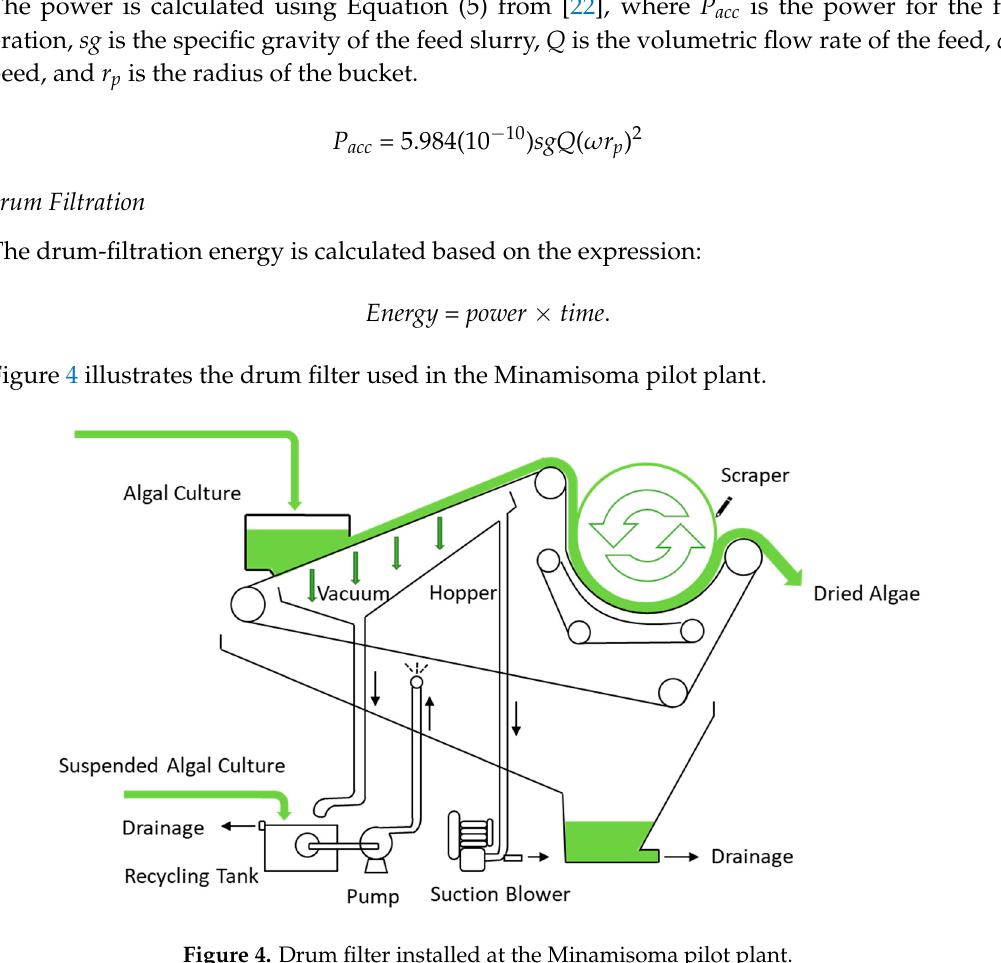
Figure 4. Drum filter installed at the Minamisoma pilot plant.